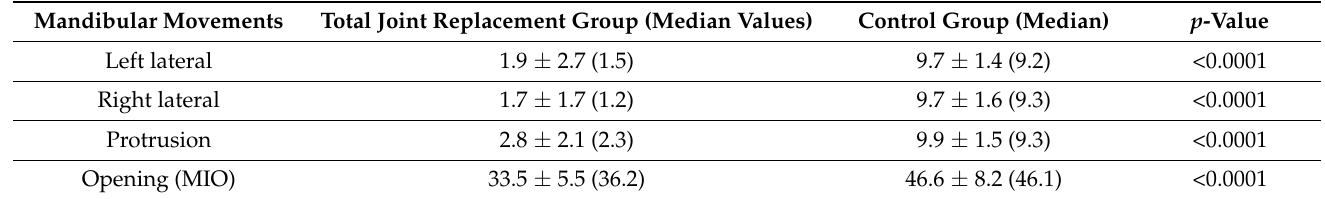
Table 3. Range of mandibular movements measured in millimeters. Values in brackets are the median